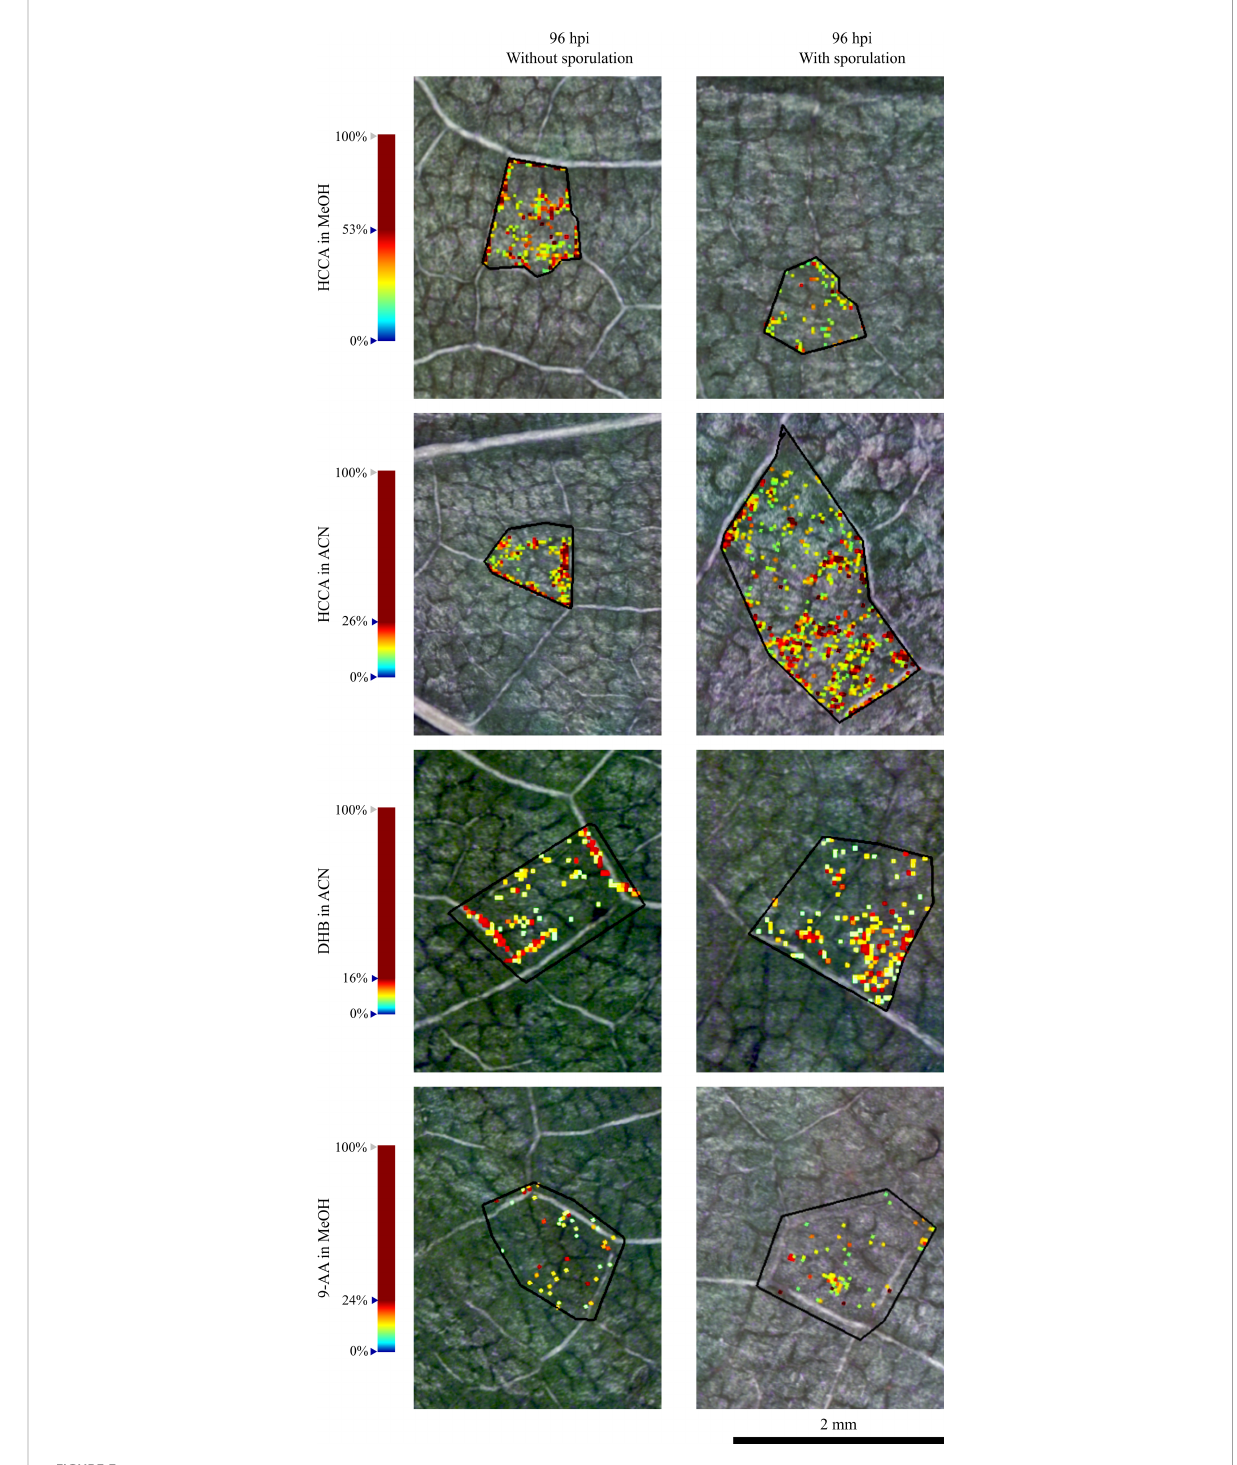
FIGURE 3 Reconstructed ion images of one selected region of putatively identi fi ed sucrose ( m/z 365.105, [M+Na] + ) in 96 hpi without visible P. viticola sporulation and 96 hpi with visible P. viticola sporulation. Leaf disc areas detected via MALDI – FT-ICR-MS imaging using HCCA matrix with MeOH and ACN, DHB matrix and 9-AA matrix. The colour scale indicates the absolute intensity of each pixel (arbitrary units). Spatial resolution: